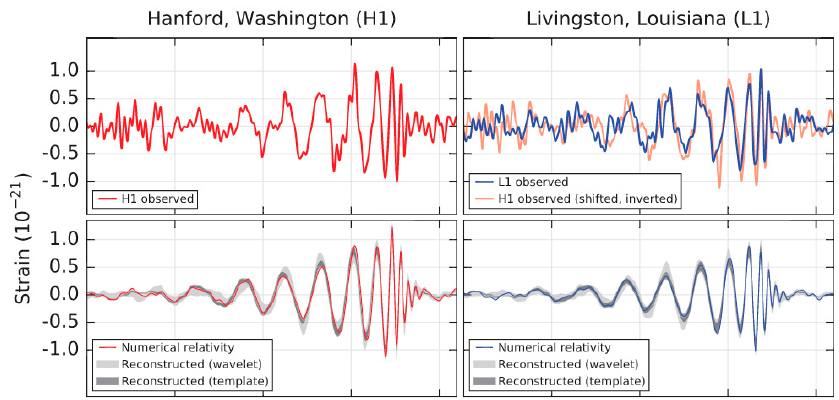
Figure 13. LIGO measurement of the gravitational waves at the Livingston (right) and Hanford (left) detectors, compared with the theoretical predicted values from General Relativity [2].